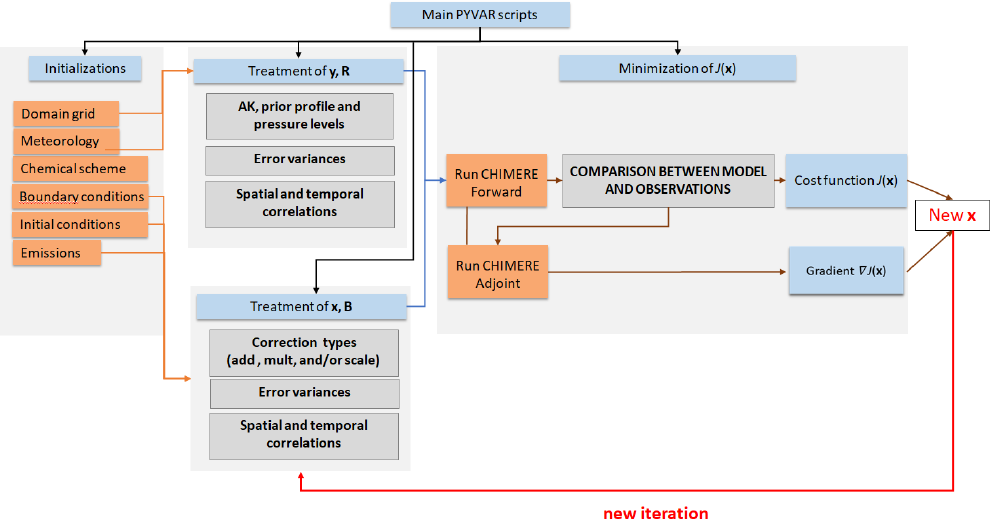
Figure 2. Simplified scheme of how PYVAR scripts are used to drive CHIMERE for an inversion using satellite observations. PYVAR, CHIMERE and text sources are displayed in blue, in orange and in grey, respectively. “AK” refers to averaging kernels as detailed in Sect.